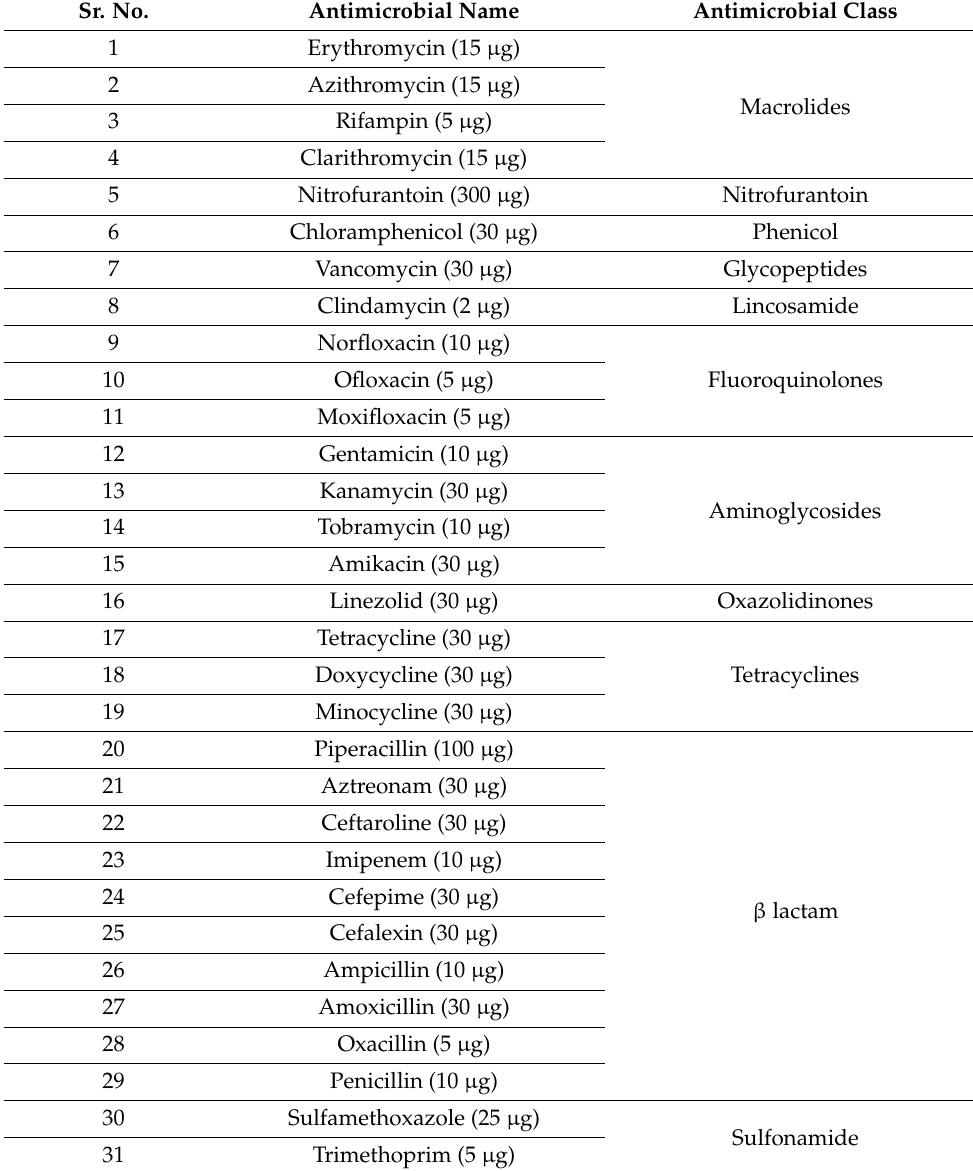
Table 2. List of antimicrobial agents used in this study. Sr.